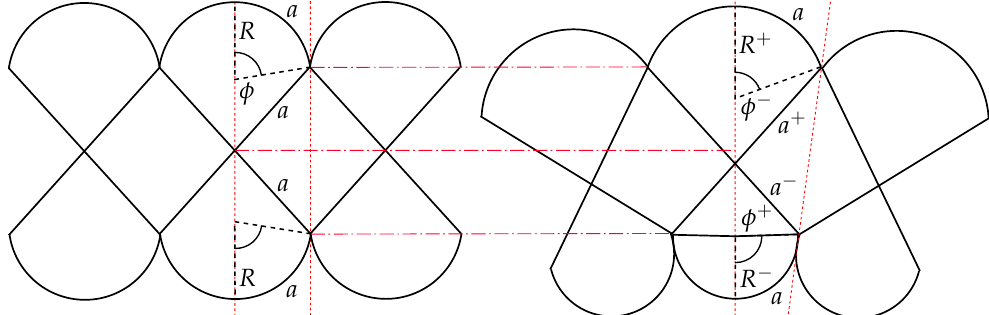
Figure 19. High flexibility of a single cross-thread layer when the cross threads are not fixed at the intersection point, with 2 a = a + + a − and a = R + φ − = R − φ + .